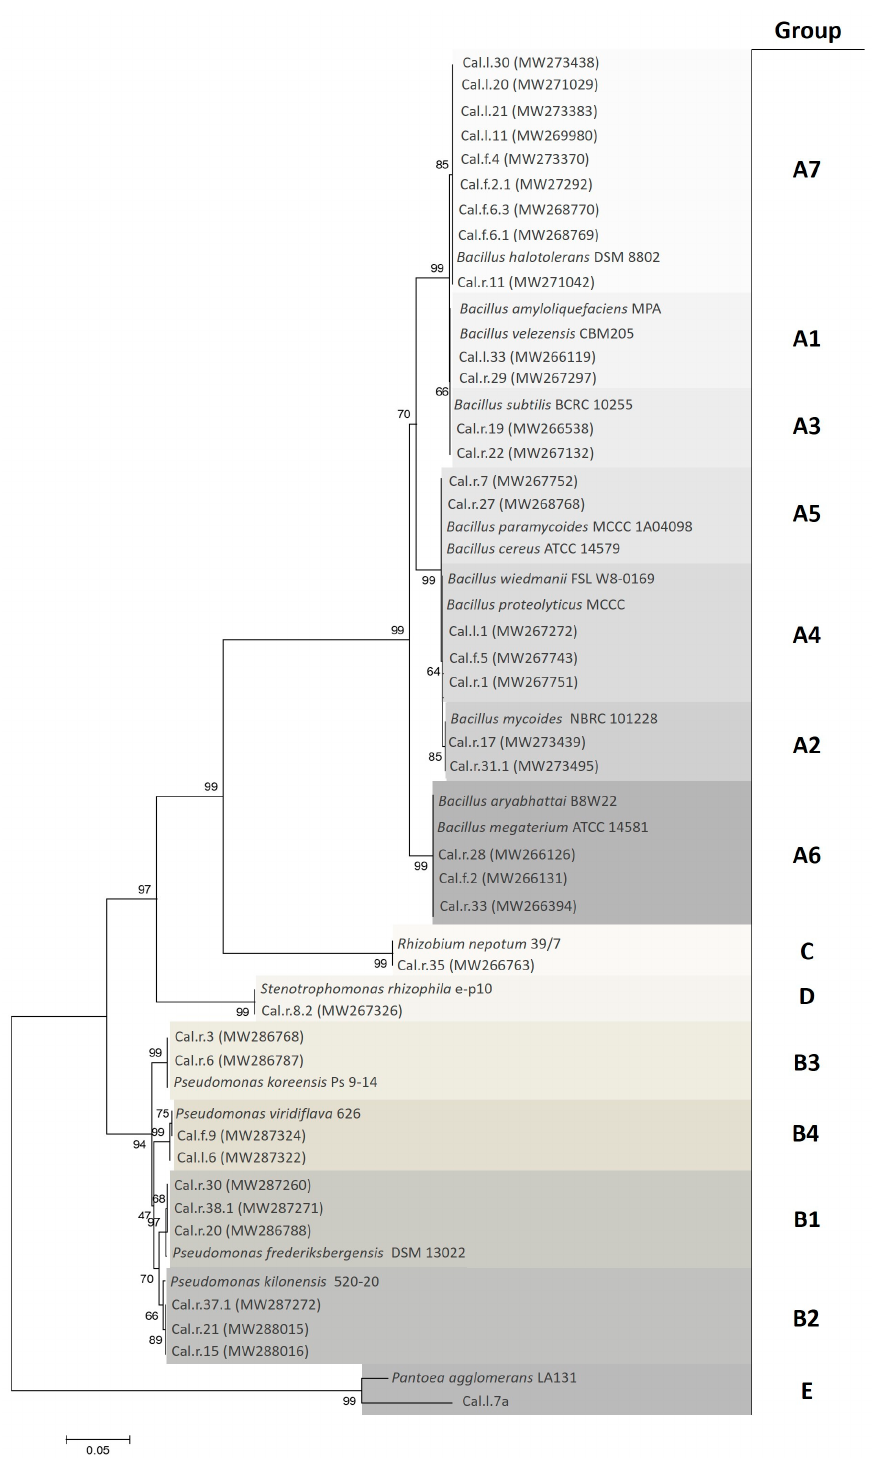
Figure 1. Phylogenetic tree based on 16S rRNA nucleotide sequences of endophytic bacterial isolates from C. officinalis . Bacterial endophytes are categorized in 14 colored groups (A1-7, B1-4, C, D and E) based on their similarity. The tree was constructed using the Neighbor-joining method with 1000 bootstrap data sets.